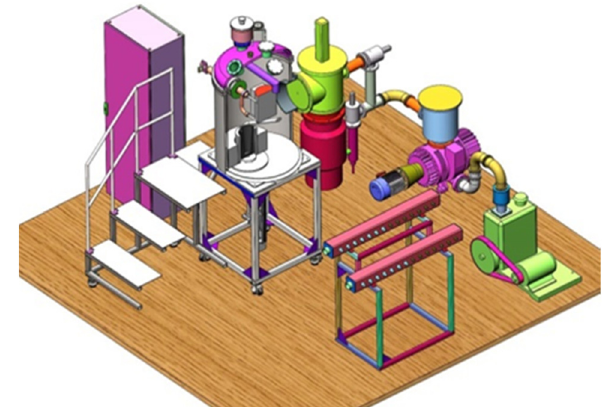
Figure 3: BRY - DZG - 10 Multifunctional vacuum melting and casting